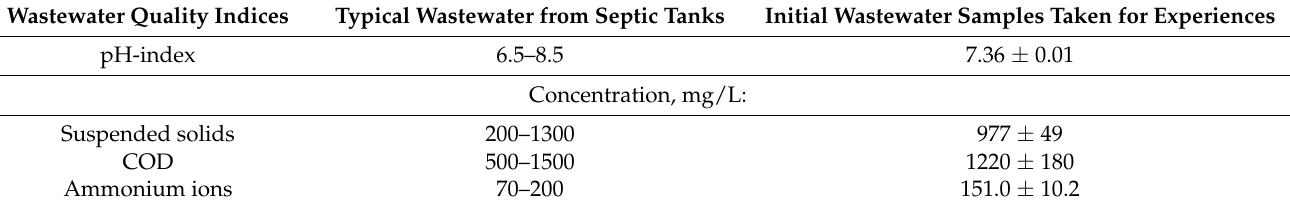
Table 1. Initial wastewater composition